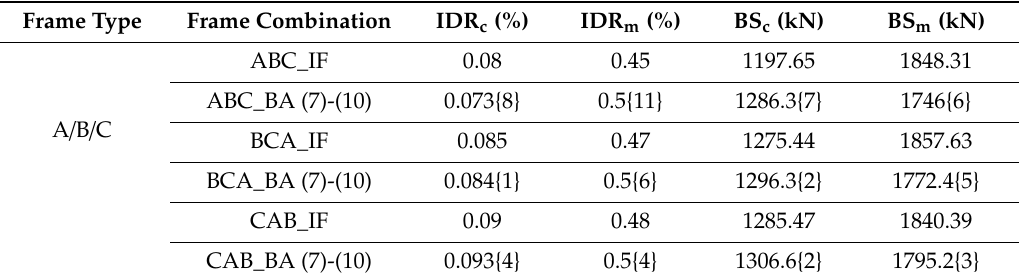
Table 11. Evaluation of accuracy of proposed bilinear approximation equations for different bay length for frames with three bays.